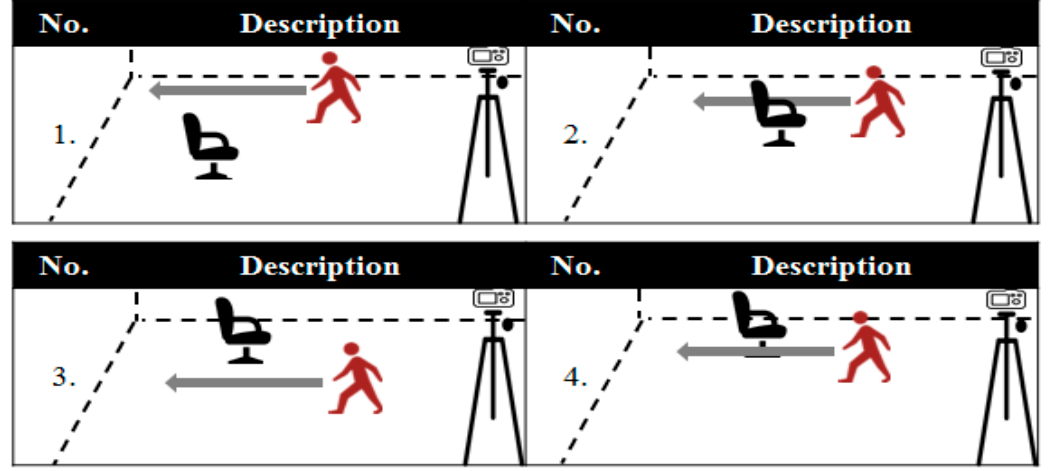
Figure 6. An illustration of the walking cases.